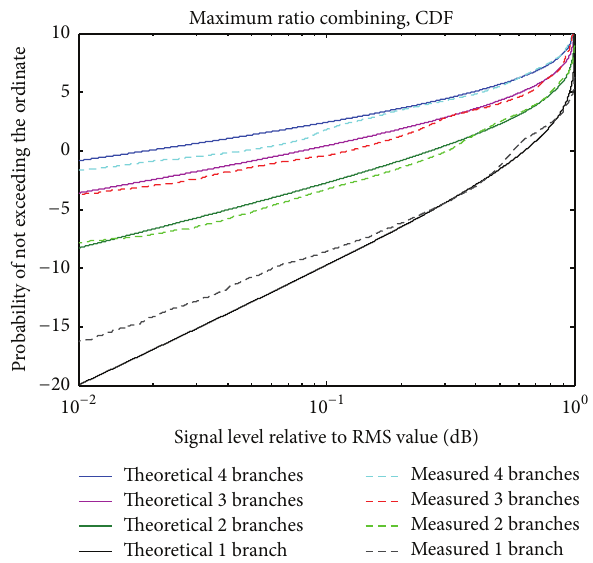
Figure 4: Comparison of CDF of MRC incremental combined signals from measurements with the MRC incremental combination of theoretical Rayleigh distribution